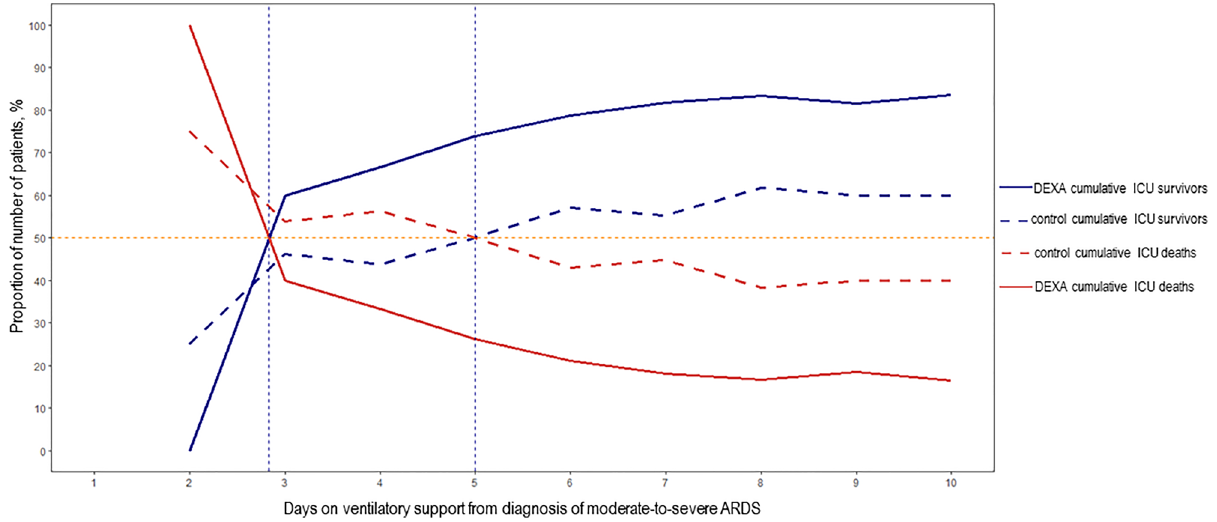
Figure 2. Percentage of cumulative number of survivors and non-survivors in the control group (n = 138) and in the dexamethasone arm (n = 139) in 277 patients with moderate-to-severe ARDS enrolled in a successful clinical trial. Each day represents the cumulative percentage of patients that have been mechanically ventilated up to that day and were discharged alive or dead at ICU discharge (see Supplementary Table S6 for details). Note: for a better view of the marked difference between the crossing points of control and treatment arms, cumulative curves of ICU survivors and ICU deaths are represented within the first 10 days after diagnosis of moderate/severe ARDS. Abbreviations: DEXA represents the dexamethasone